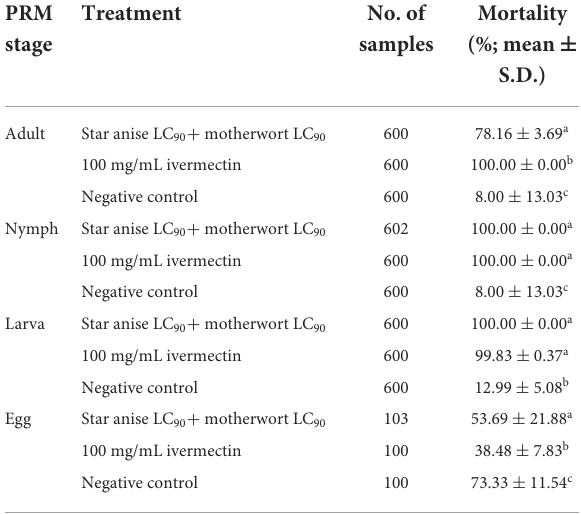
after 48 and 72h) and thyme (84% at 72 h) at a dose of